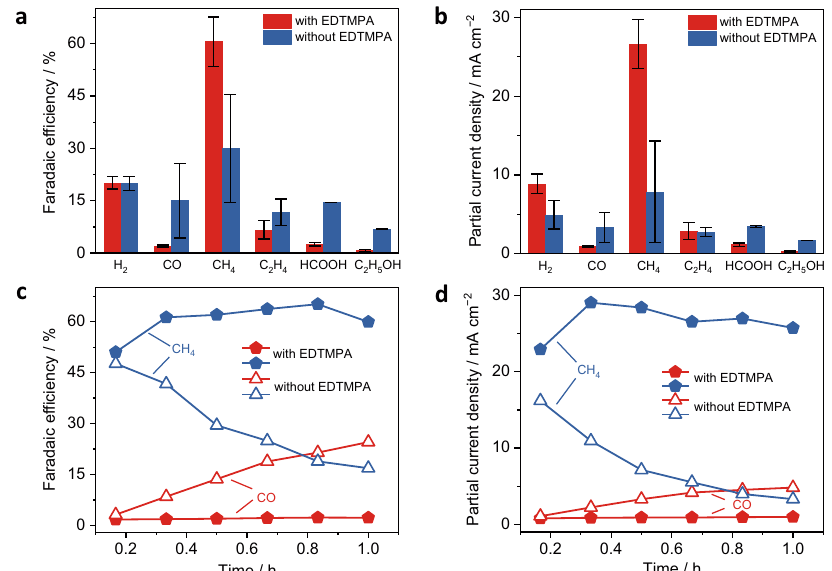
Fig. 1 CO 2 electroreduction performance in an H-cell. a , b Comparison of average FEs ( a ) and partial current densities ( b ) of various products at − 1.0 V versus RHE in the electrolytes with and without EDTMPA during one-hour testes. The error bars in a and b represent mean absolute deviation. c , d Stability of FEs ( c ) and partial current densities ( d ) of the CO and CH 4 products in the electrolytes with and without